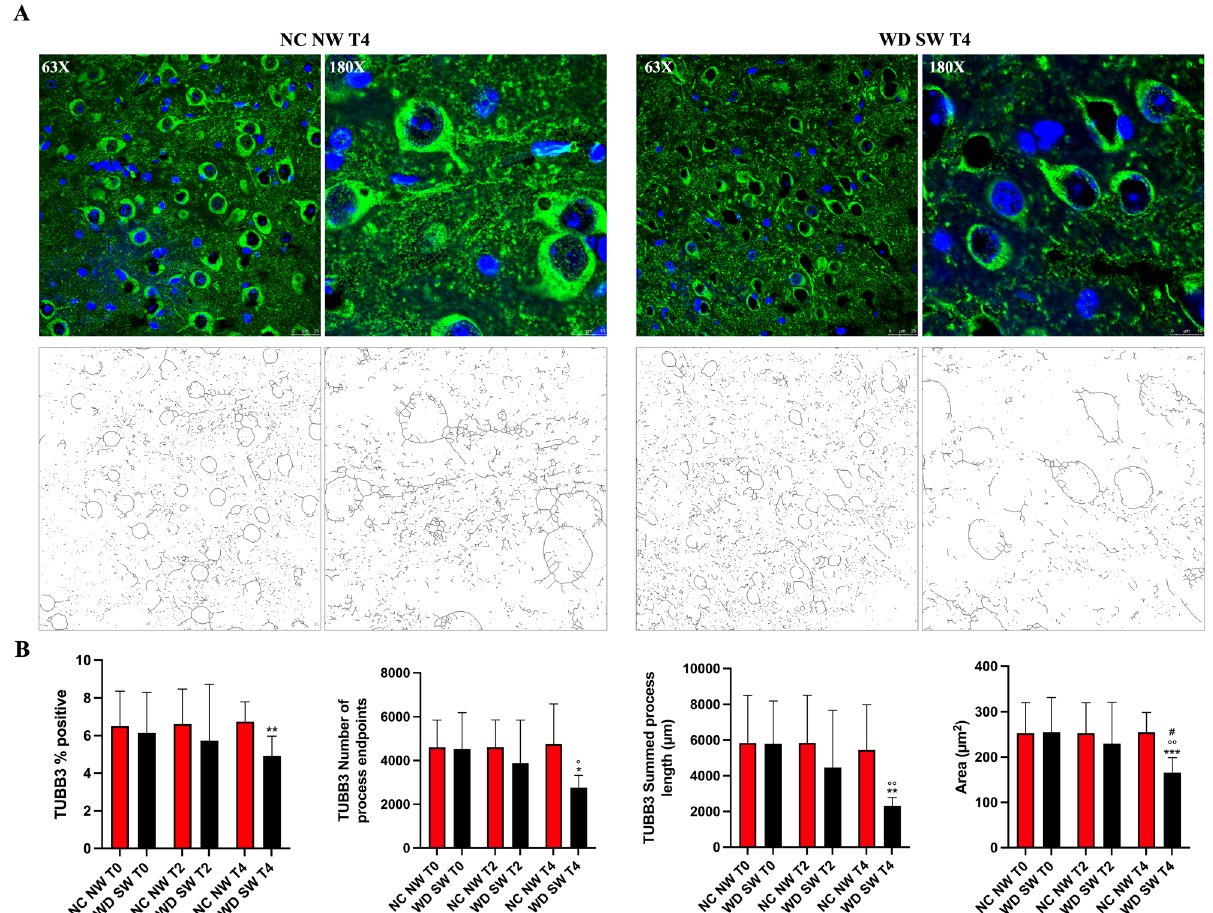
Figure 5. Immunofluorescence staining for TUBB3 in neurons. (A) Representative confocal 63X and 180X images (above) and respective 63X and 180X skeletonized images (below) of TUBB3 positive neurons at T4 (28 weeks) (B) The results are expressed as mean ± S.D. NC NW: Normal Chow Normal Water; WD SW: Western Diet Sugar Water. T0: 0 weeks; T2: 8 weeks; T4: 28 weeks. TUBB3: anti-β III Tubulin. *: p < 0.05, **: p < 0.01, ***: p < 0.001 vs NC NW T4; °: p < 0.05, °°: p < 0.01 vs WD SW T0; #: p < 0.05 vs WD SW